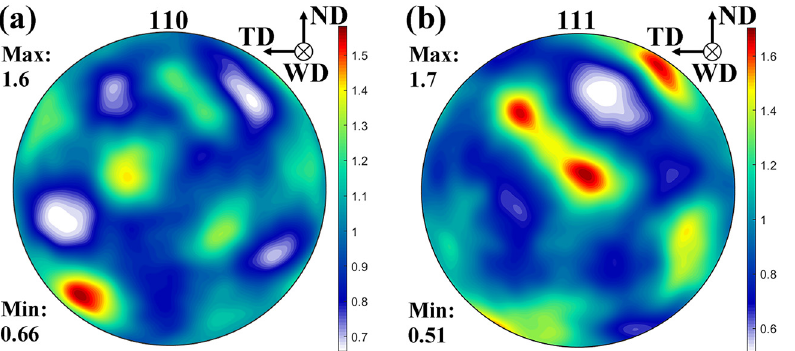
Figure 13: ( a ) { 110 } , and ( b ) { 111 } pole figures of the weld produced at rotational speed of 300 rpm presented in ND - TD - WD